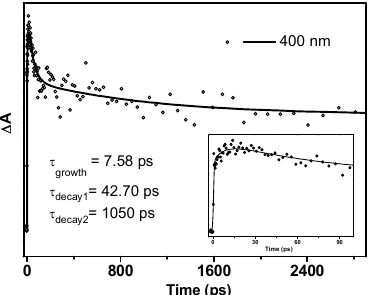
Figure 5. Kinetics of the absorption band at 400 nm acquired by fs-TA experiments of DMB in MeCN. (Inset) The enlargement of the kinetics from 0 to 100 ps. The solid line depicts the best fit to the data. As shown in Figure 6a, a new species with a maximum absorption band at 400 nm and a shoulder band at 480 nm were observed (denoted as X 480 ). Species X 480 was long-lived and its decay time constant was determined to be 47.9 µ s (Figure 6b). Figure 6c (red line) presents the simulated